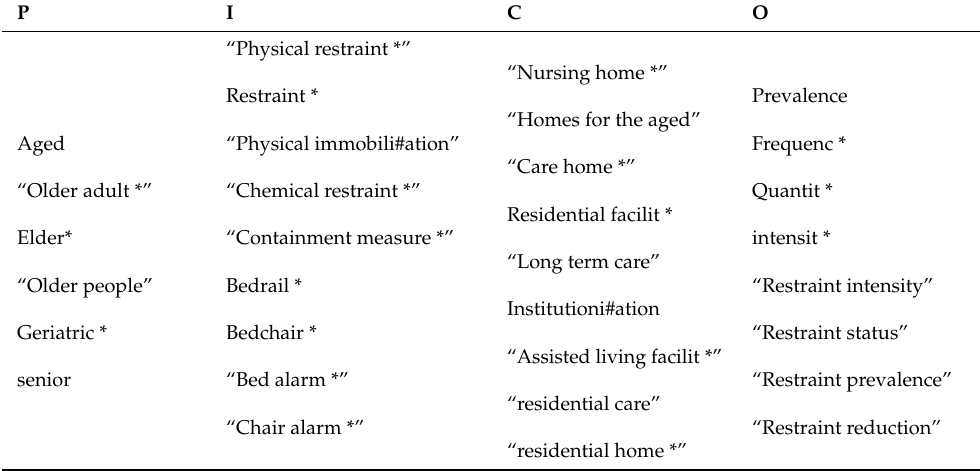
Table A1. Search Strategy Using a Modified PICO